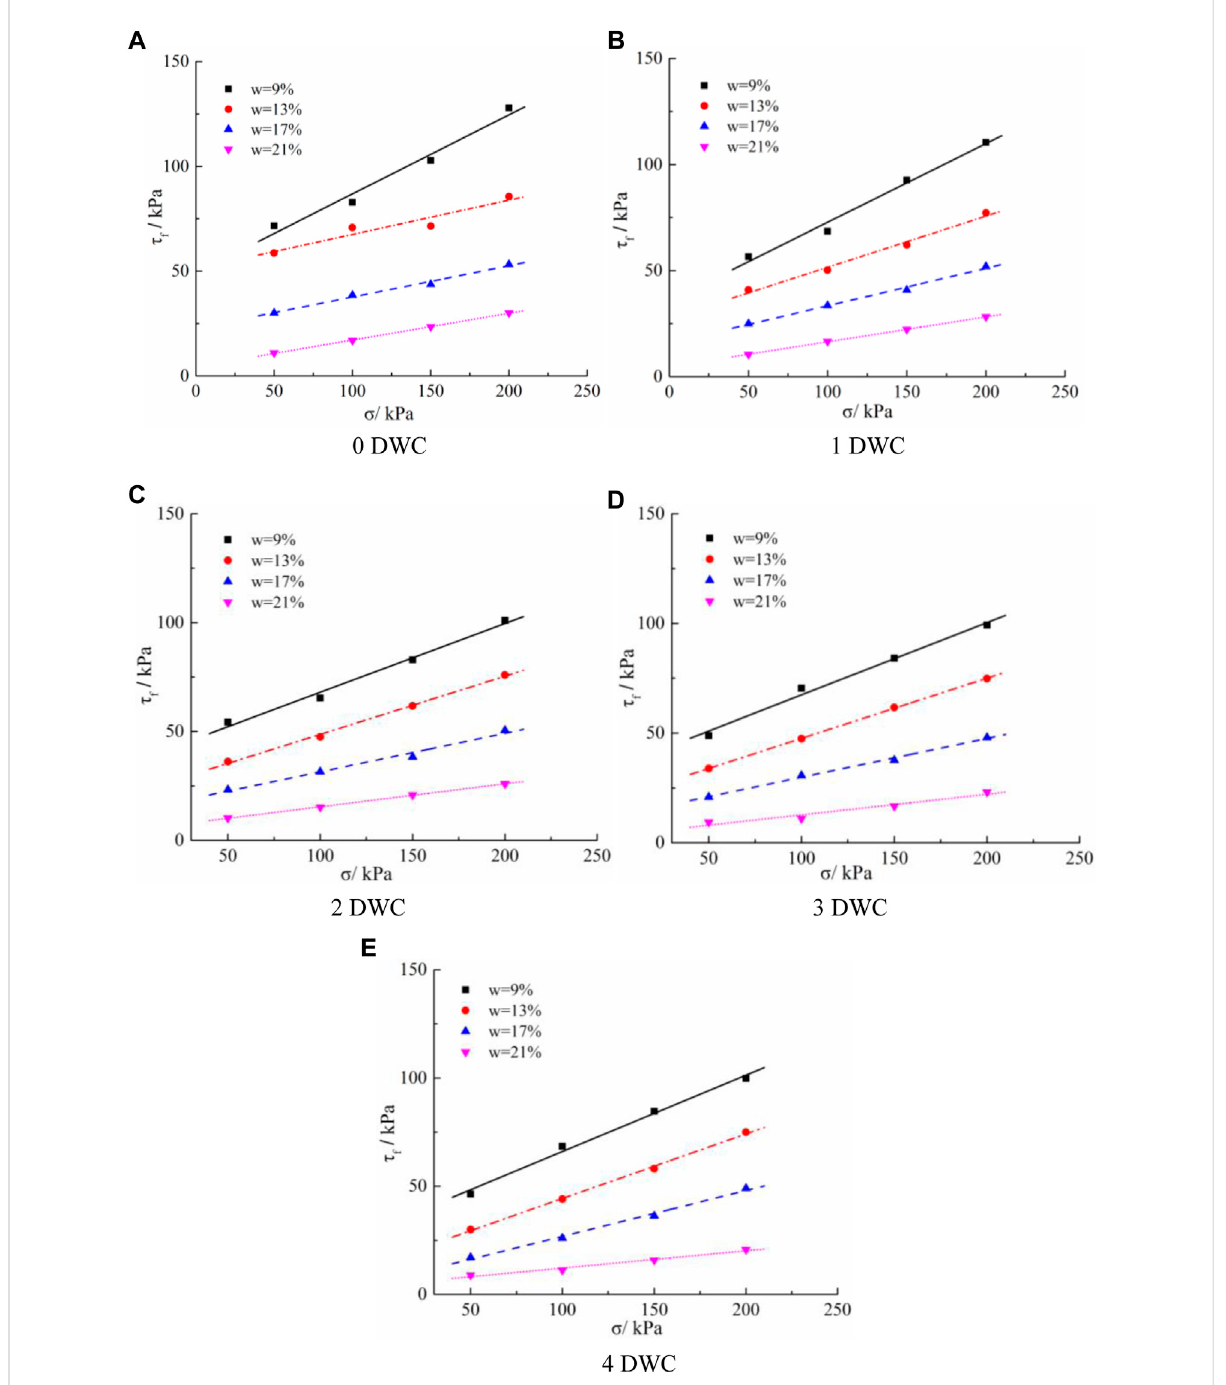
FIGURE 3 Relationship between the shear strength and the normal stress of samples with the different water contents (A) . 0 DWC (B) . One DWC (C) . Two DWC (D) . Three DWC (E) .Four